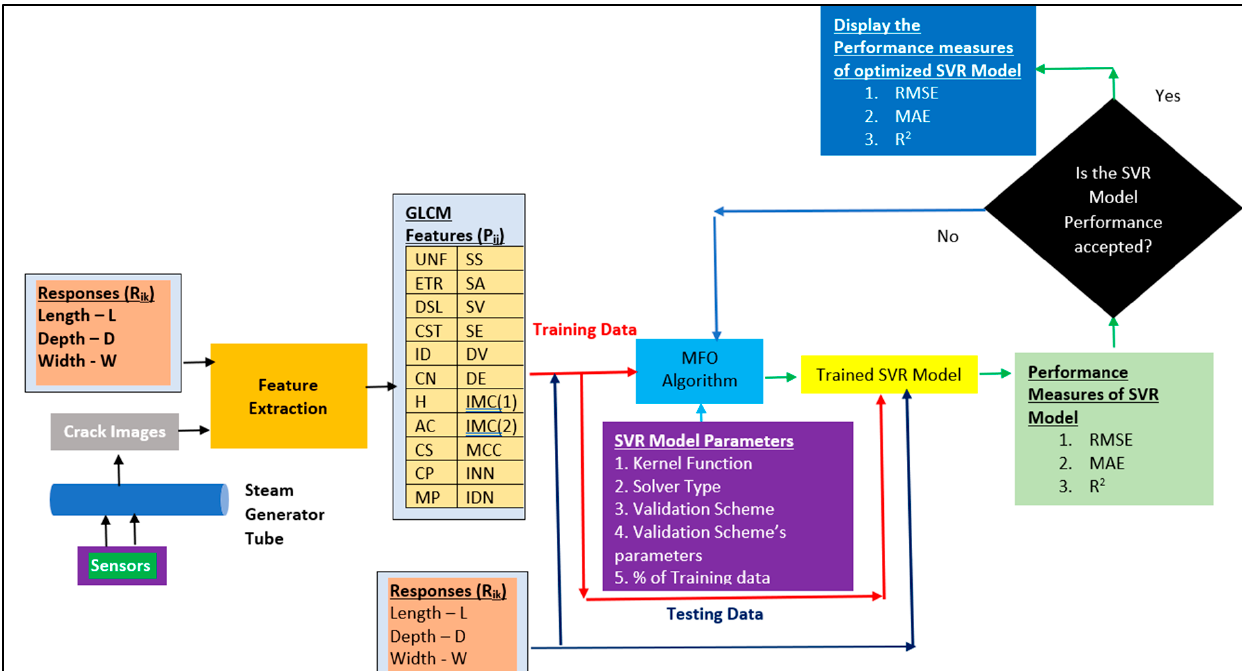
Figure 1. Proposed methodology.